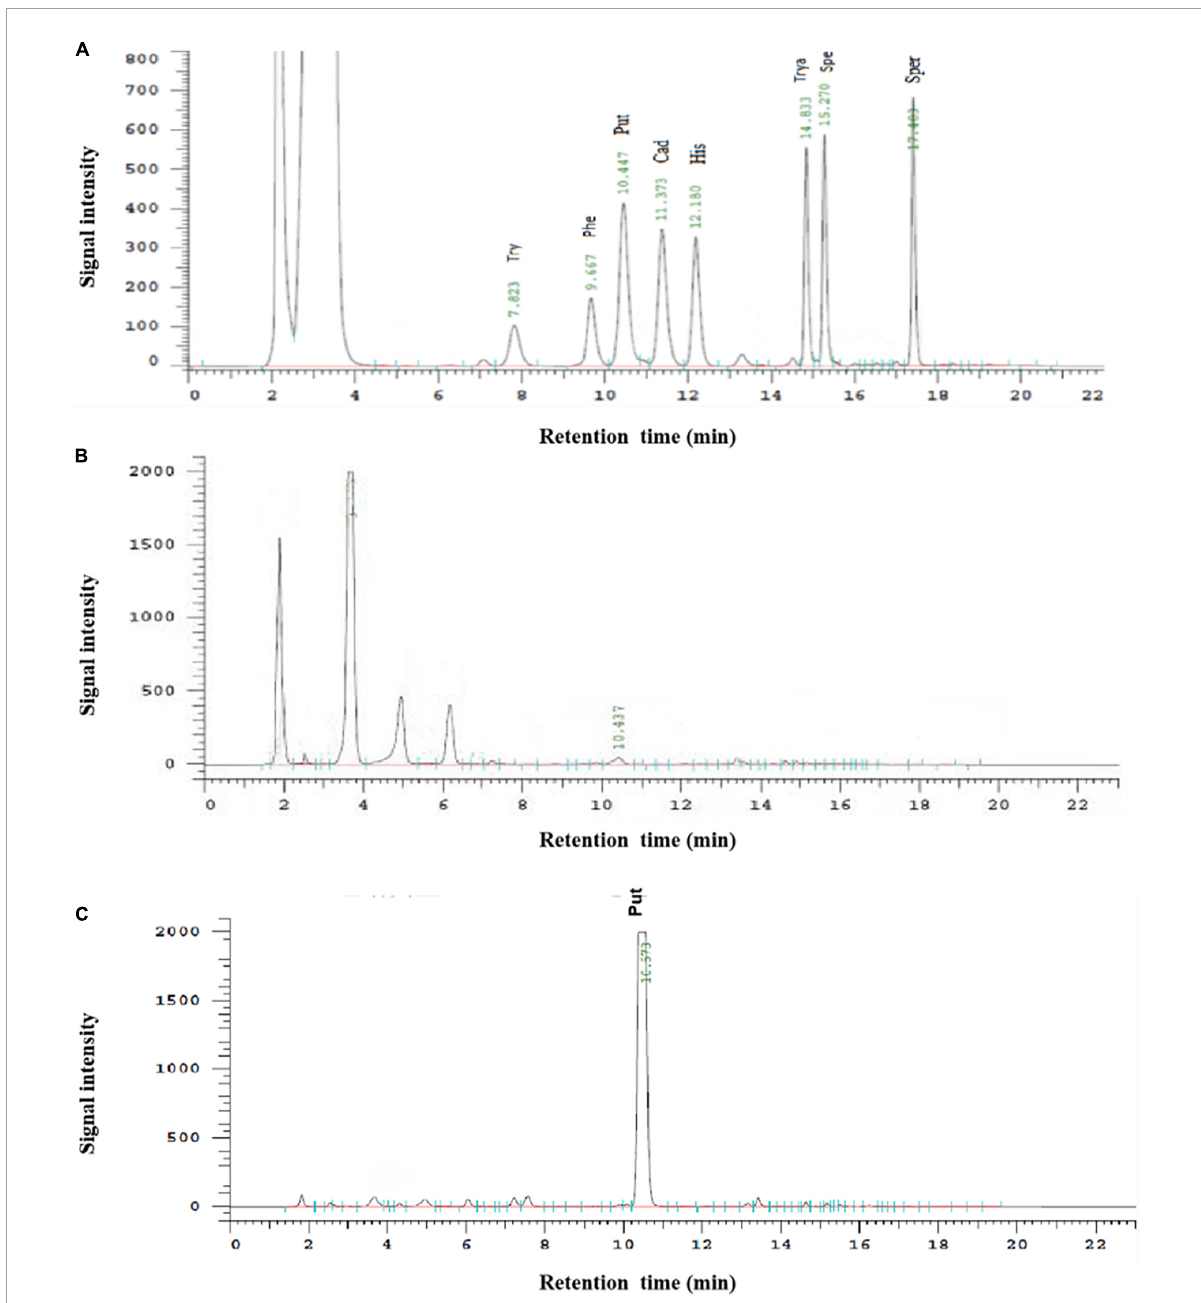
FIGURE8 The HPLC determination of biogenic amines. (A) Represented the HPLC determination result of the mixture of eight biogenic amines standards. (B) Represented the HPLC determination result of the negative control. (C) Represented the HPLC determination result of hetero-expressed